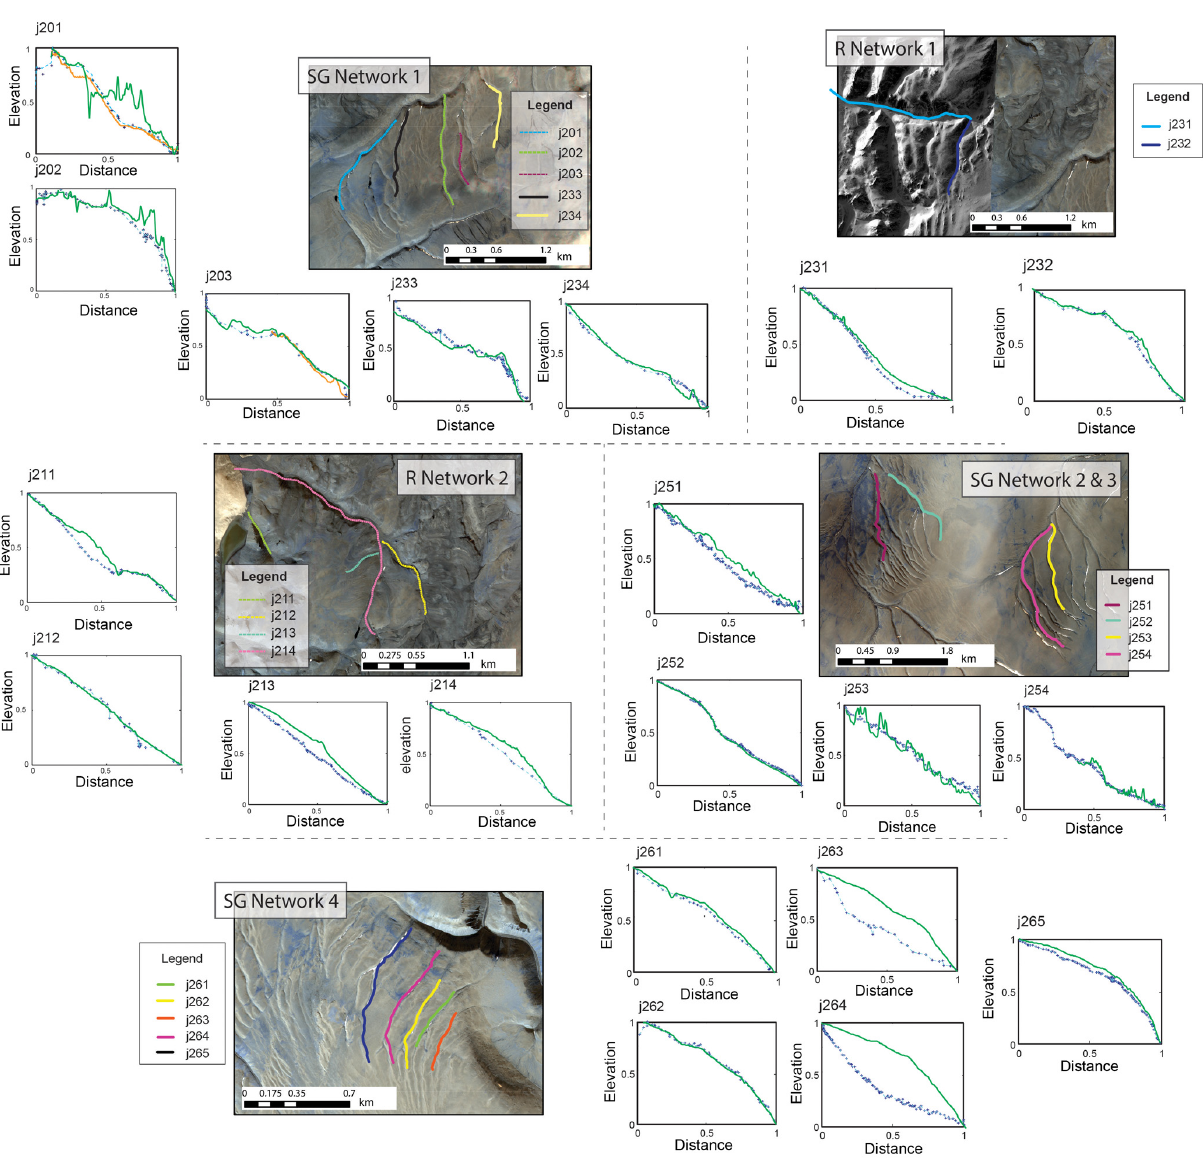
Figure 3. Longitudinal profiles of river and subglacial channels normalized to total topographic loss and length along the channel, with WorldView satellite imagery for each channel network. In the longitudinal profiles, blue crosses represent the raw GPS data for each channel, blue dashed lines are the data after filtering, and orange solid lines represent the lidar sections that overlap GPS data for comparison. The profiles obtained with the Arctic DEM at 5m resolution are shown in green